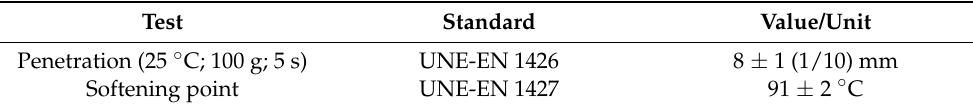
Table 6. Tests of binder extracted from reclaimed asphalt pavement (RAP).